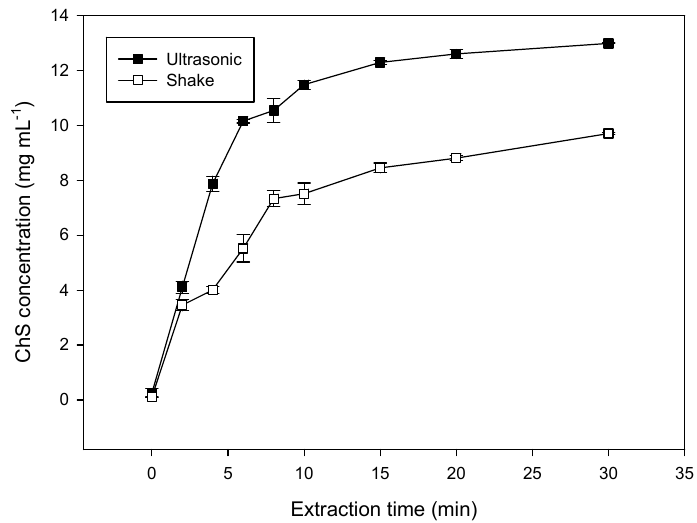
Figure 1. Comparison between conventional shaking extraction and UAE methods on the extraction of ChS. The UAE was performed at 37 kHz, 3% NaOH, and 50 °C, and the conventional shaking of ChS. The UAE was performed at 37 kHz, 3% NaOH, and 50 ◦ C, and the conventional shaking extraction was performed at 100 rpm, 3% NaOH, and 50 °C. extraction was performed at 100 rpm, 3% NaOH, and 50 ◦